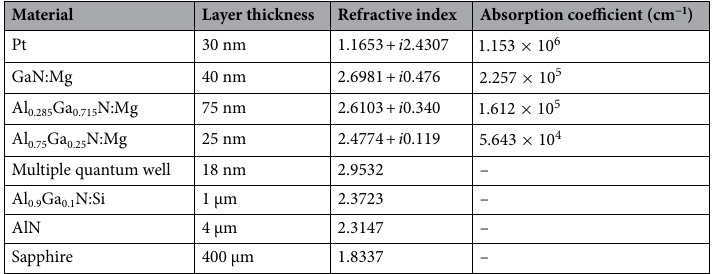
Table 1. The materials used for the simulated devices, including their refractive index and absorption coefficient at 265 nm wavelength, and thicknesses in the planar reference device. Layer thicknesses and material compositions were taken from 31–33 , for Al 0.75 Ga 0.25 N:Mg a linear interpolation scheme was used to obtain both refractive index and absorption coefficient 34